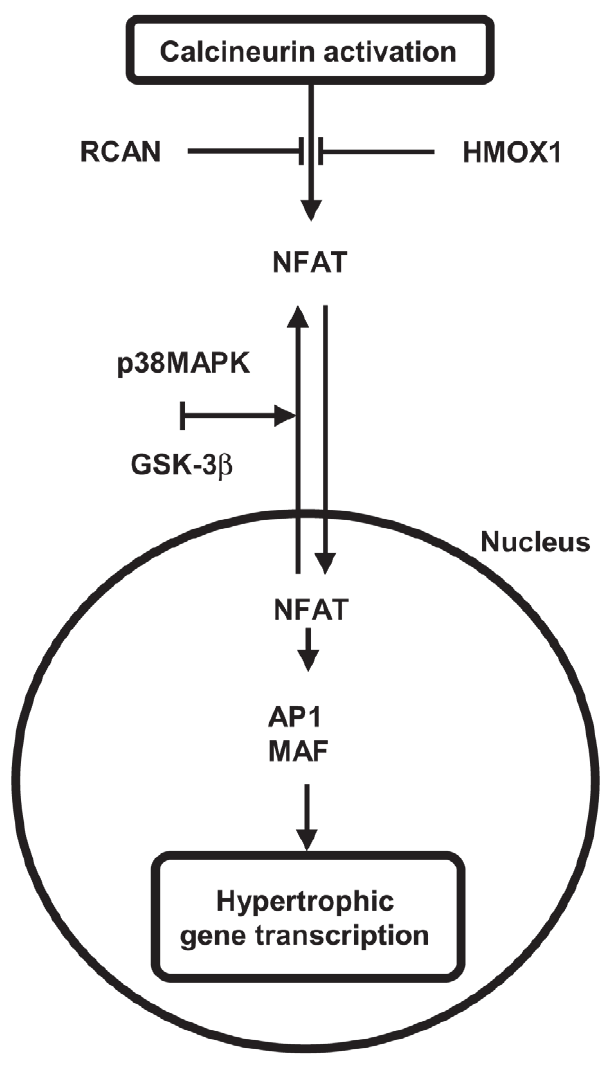
Figure 7. Regulatory and downstream targets of NFAT transcriptionally active following a single bout of eccentric exercise. p38MAPK – p38 mitogen activated protein kinase; GSK-3 b – glycogen synthase kinase 3 beta; MAF – v-maf musculoaponeurotic fibrosarcoma oncogene homologue (avian).